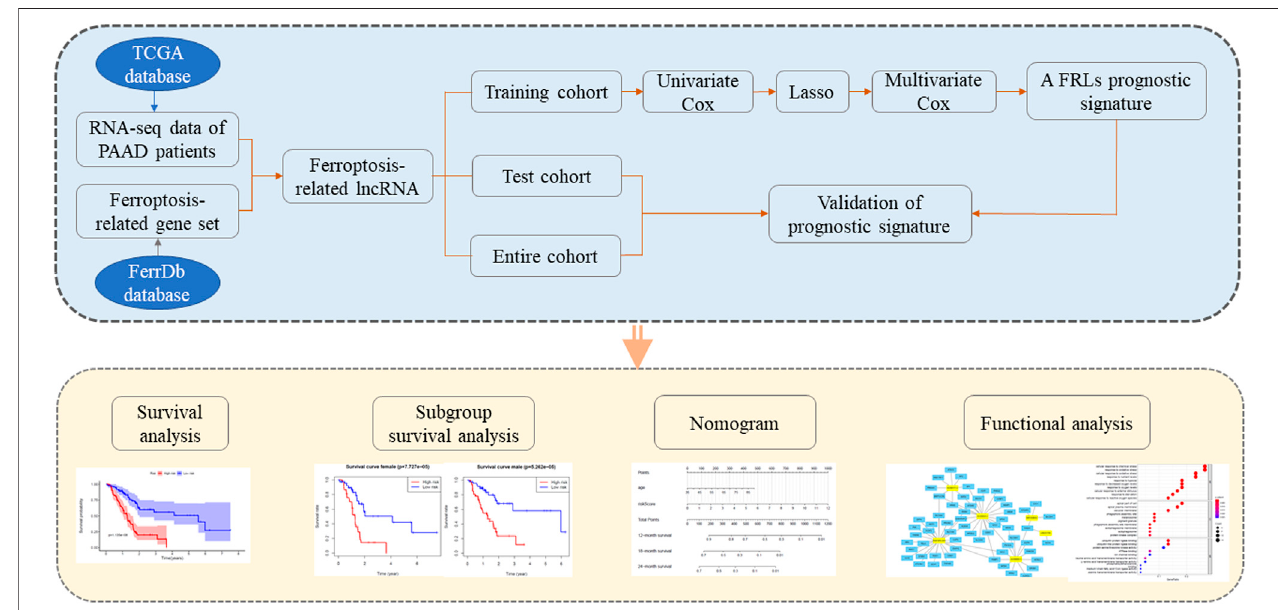
FIGURE 1 | Flow chart of the